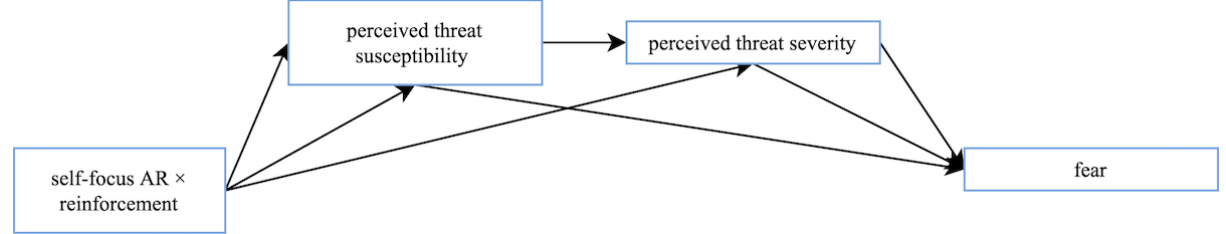
Figure 14. The self-focus augmented reality (AR) × reinforcement, susceptibility, severity, and fear mediation model. The self-focus AR × reinforcement condition resulted in an indirect effect on fear through threat susceptibility and threat